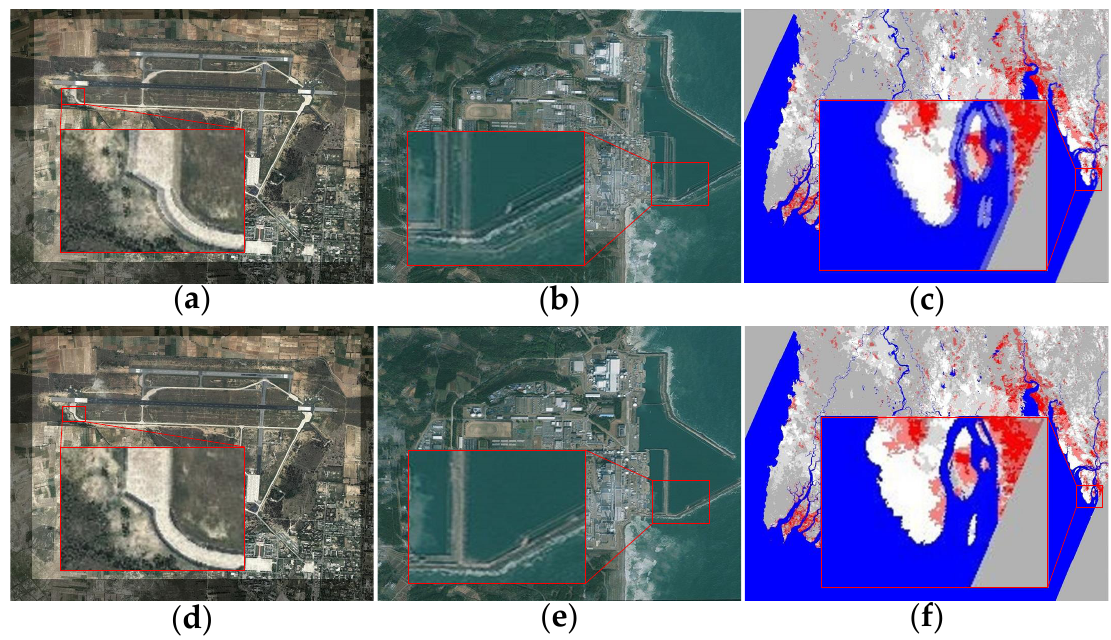
Figure 11. Illustration of the registration results. ( a ) Results of mean-standard deviation line descriptor (MSLD) on Data set 2-1; ( b ) results of scale-invariant feature transform (SIFT) on Data set 2-2; ( c ) results of line matching leveraged by point correspondences (LP) on Data set 2-3; ( d ) results of RLI on Data set 2-1; ( e ) results of RLI on Data set 2-2; and ( f ) results of RLI on Data set